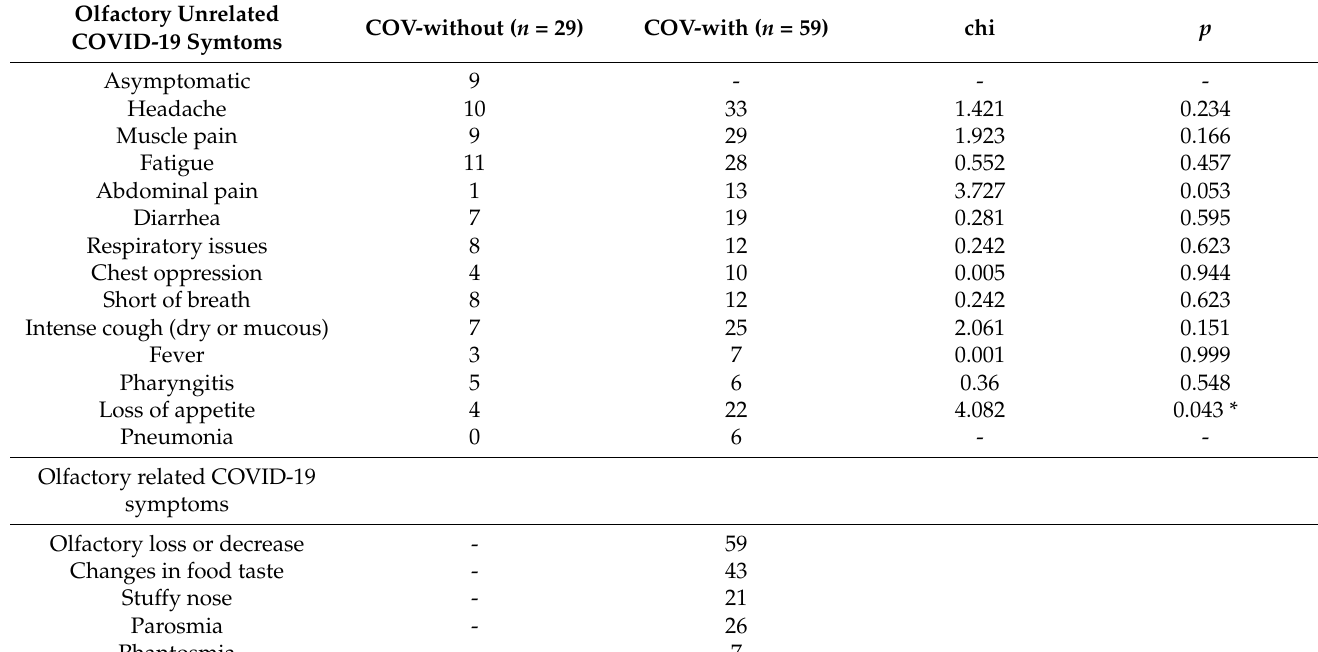
Table 2. Olfactory unrelated symptomatology of COVID-19